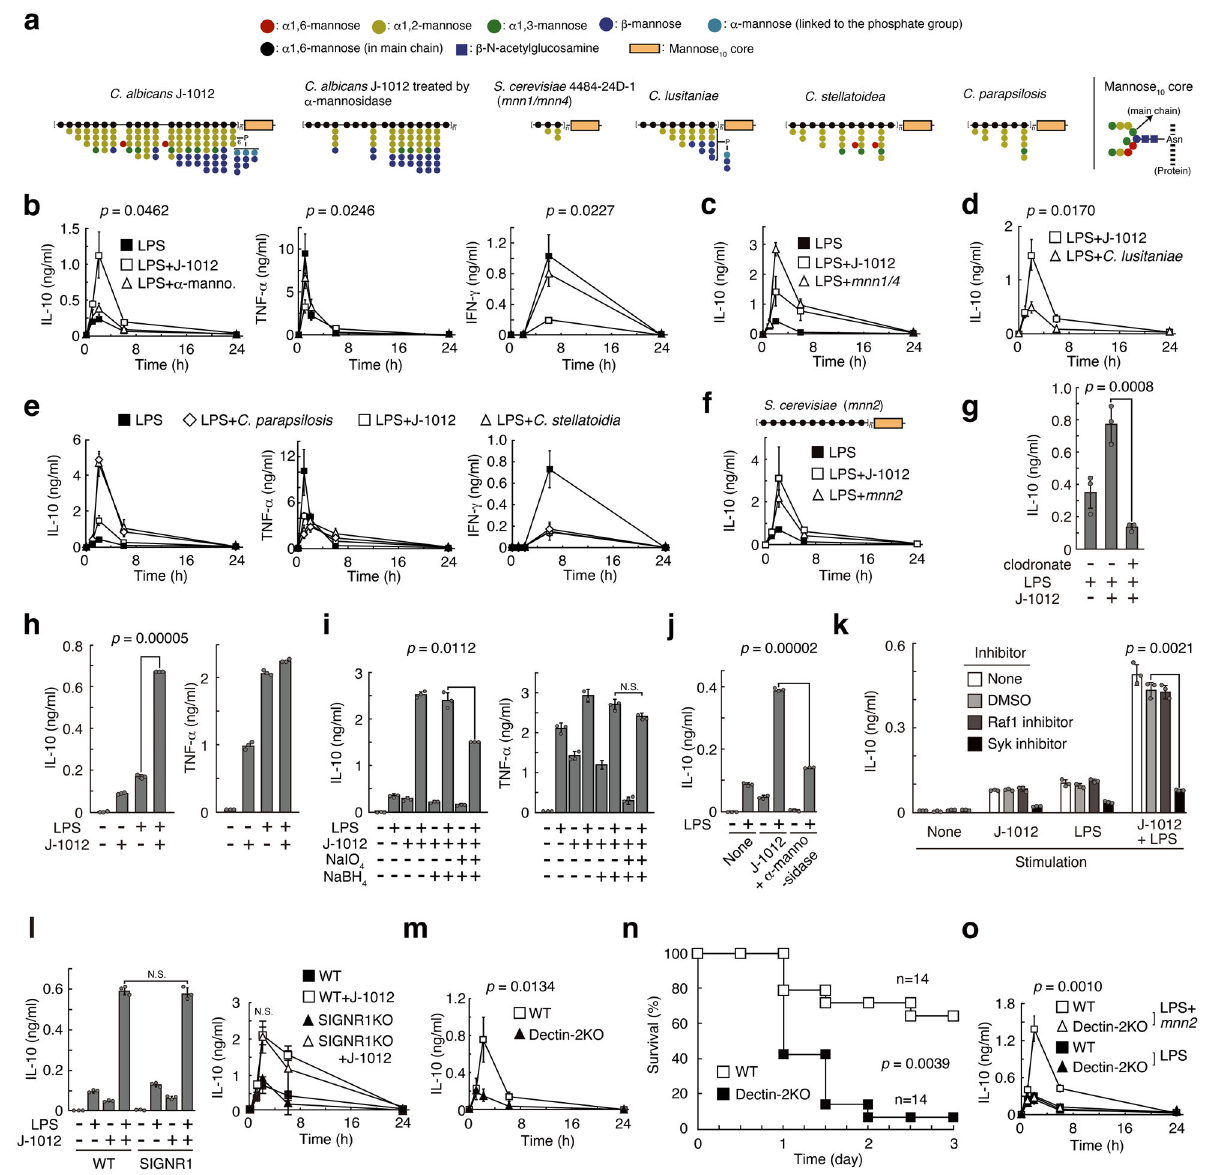
Fig. 2 α -mannans of N-glycan of C. albicans are involved in augmentation of IL-10 through Dectin-2. a Schematic structures of N-glycans and mannose core (black circle; α 1,6-mannose (in main chain), blue circle; β -mannose, green circle; α 1,3-mannose, light blue circle; α -mannose (linked to the phosphate group), red circle; α 1,6-mannose, yellow circle; α 1,2-mannose, light brown rectangle; Mannose 10 core). b – f Analyses of serum cytokines after i.v. injection with LPS and J-1012 N-glycan treated with α -mannosidase ( b ), S. cerevisiae ( mnn1/mnn4 ) ( c ), C. lusitaniae ( d ), C. parapsilosis and C. stellatoidea ( e ), and S. cerevisiae ( mnn2 ) ( f ) N-glycan as in Fig. 1a. g Serum IL-10 of 2 h after i.v. injection with LPS and J-1012 N-glycan in mice pre-treated by clodronate liposome. h – k Cytokine production by rpM ϕ after stimulation by LPS for 24 h on plates coated with intact ( h , k ), NaIO 4 treated ( i ) or α -mannosidase treated ( j ) J-1012 N-glycan. Effects of signaling inhibitors on IL-10 production by rpM ϕ ( k ). l IL-10 production of SIGNR1KO rpM ϕ in response to plate-coated J-1012 N-glycan (left panel) and serum IL-10 in SIGNR1KO mice as in Fig. 1a (right panels). m Serum IL-10 in Dectin-2KO mice upon stimulation with LPS in the presence of J-1012 N-glycan as in Fig. 1a. n Survival of WT and Dectin-2KO mice as in Fig. 1h. The experiment was repeated twice, and compiled results are shown. o Serum IL-10 in Dectin-2KO mice after injection with N-glycan from S. cerevisiae X2180-1A-5 ( mnn2 ). b – m , o Data are expressed as the mean ± SD ( n = 3) ( b – l ), ( n = 4) ( m ) and ( n = 4) ( o ), and are representative of at least two independent experiments. In ( b ), ( c ), ( l right panel) and ( o ), statistical analyses were performed between LPS + J-1012 and LPS + J-1012 with α -mannosidase, LPS + J-1012 and LPS + mnn1/4 , WT + J-1012 and SIGNR1KO + J-1012, and WT + mnn2 + LPS and Dectin-2KO + mnn2 + LPS, respectively. b , d , l (right panel), m , o , p value at the peak point of cytokine production was determined by unpaired two-tailed Student ’ s t -test. g – l p value was determined by unpaired two-tailed Student ’ s t -test. N.S., not signi fi cant ( p > 0.05). n p value was determined by the Wilcoxon